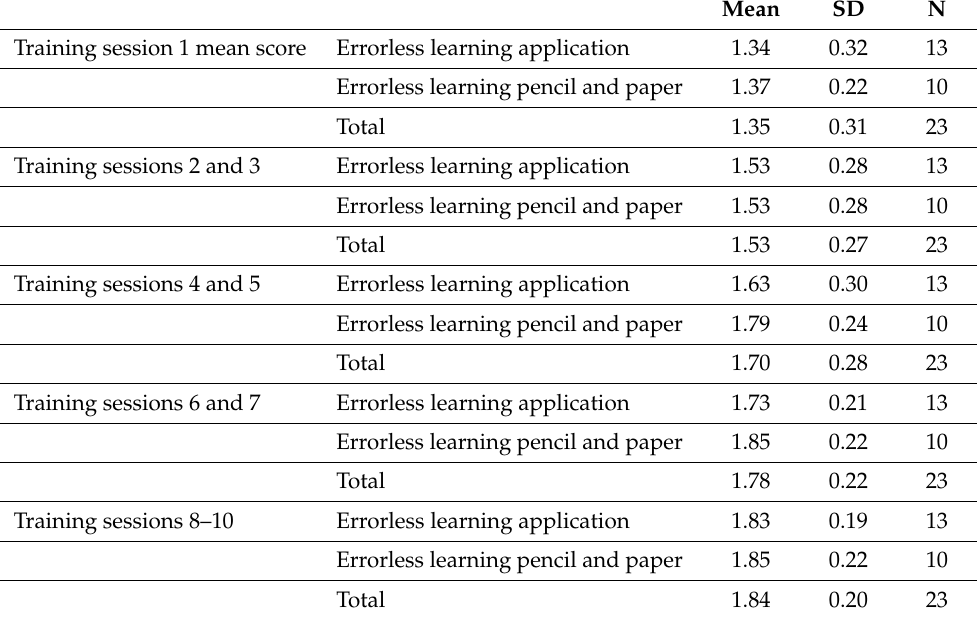
SD = Standard Deviation, N = number of